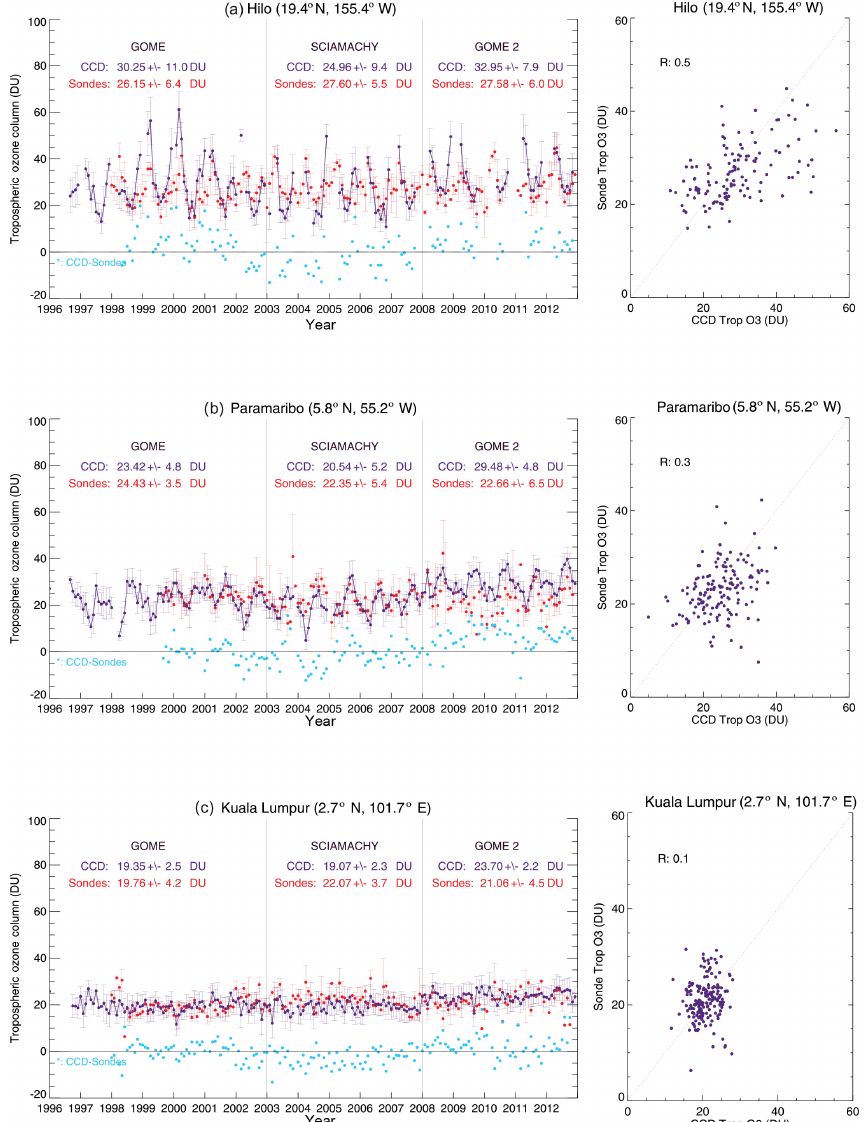
Figure 12. Time series of monthly-mean CCD tropospheric ozone columns and collocated monthly-mean SHADOZ ozonesonde TTCO in Hilo, Paramaribo, and Kuala Lumpur (from top to bottom). The red lines give the integrated ozone column from sonde ozone up to the fixed level of 200hPa (roughly 12km). The blue lines are (i) GOME-1 CCD ozone columns (1996–2002), (ii) SCIAMACHY CCD ozone columns (2003–2007), and (iii) GOME-2 CCD ozone columns (2008–2012). Error bars indicate the standard deviation of the monthly mean. No error bars are shown for months with only one ozonesonde launch available. The difference between CCD and ozonesondes is plotted with light blue